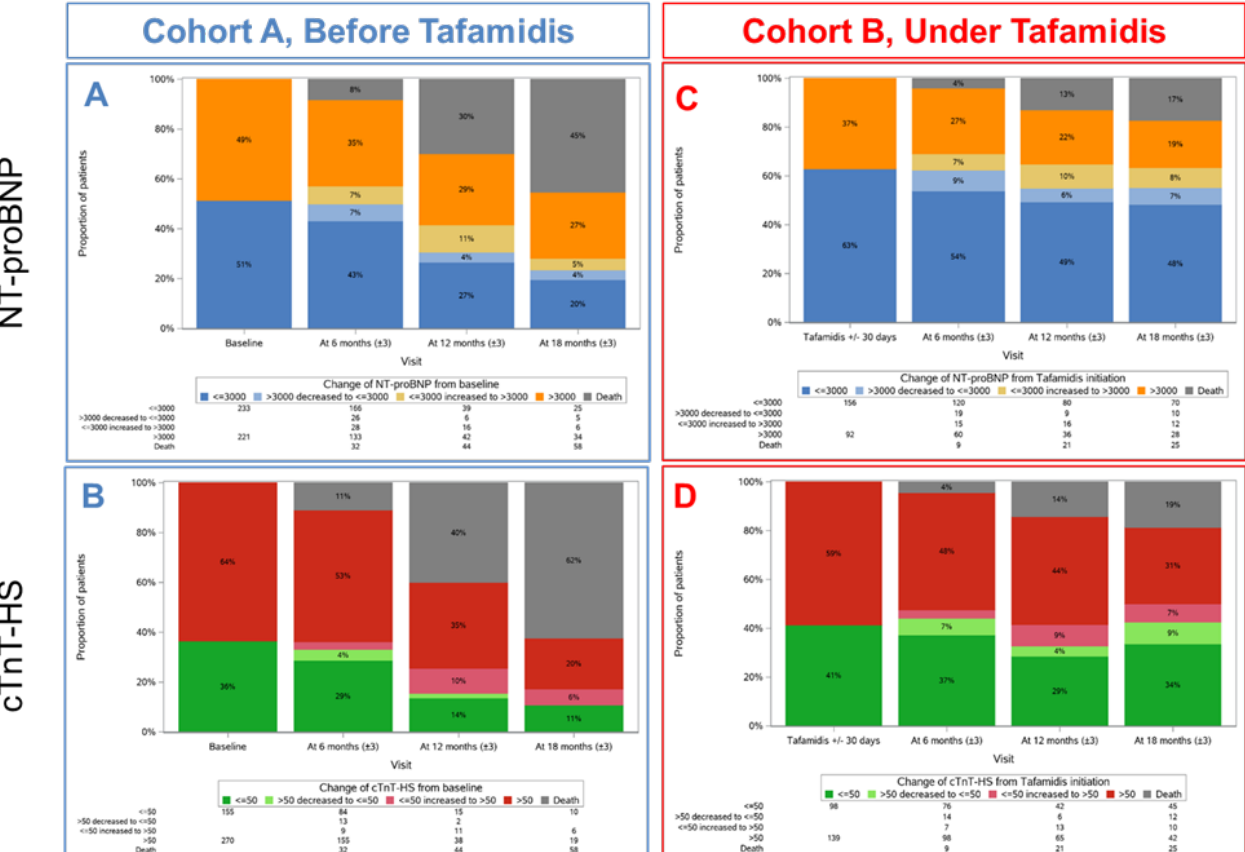
Figure 3. Proportion of patients in Cohort A ( n = 454) that maintain NT-proBNP ( A ) and cTnT-HS ( B ) levels at 6, 12, and 18 months relative to their baseline levels and proportion of patients in Cohort B ( n = 248) Proportion of patients in Cohort B ( n = 248) that maintain NT-proBNP ( C ) cTnT-HS ( D ) levels at 6, 12, and 18 months relative to their baseline levels.